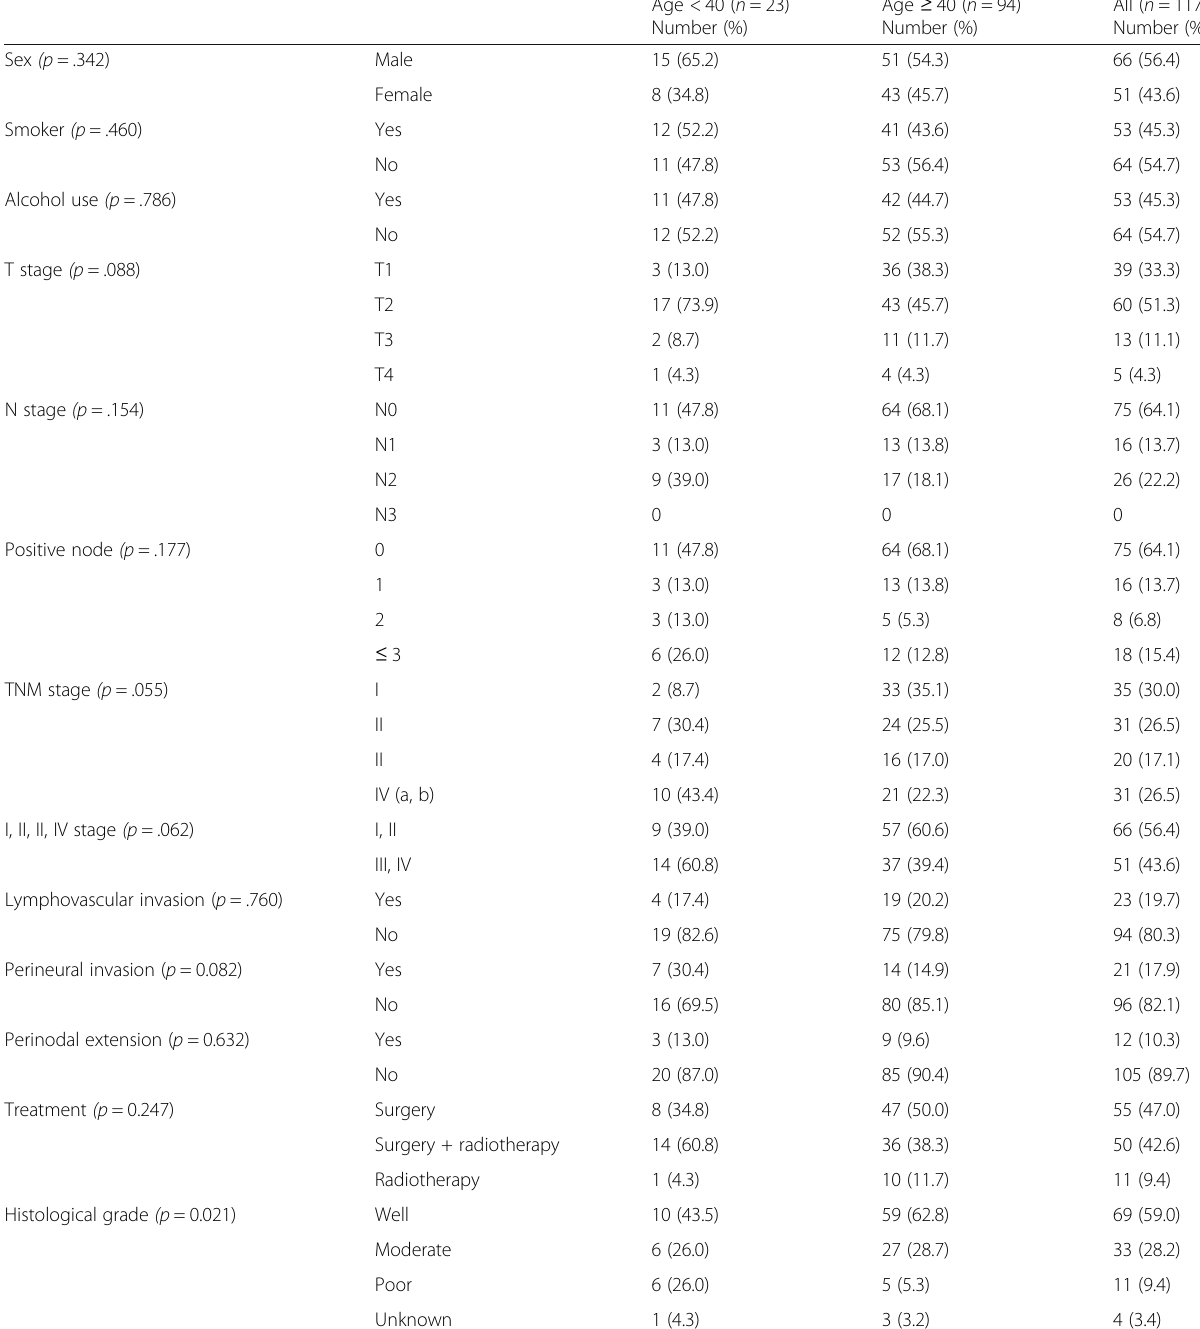
Age < 40 ( n = 23) Number (%)